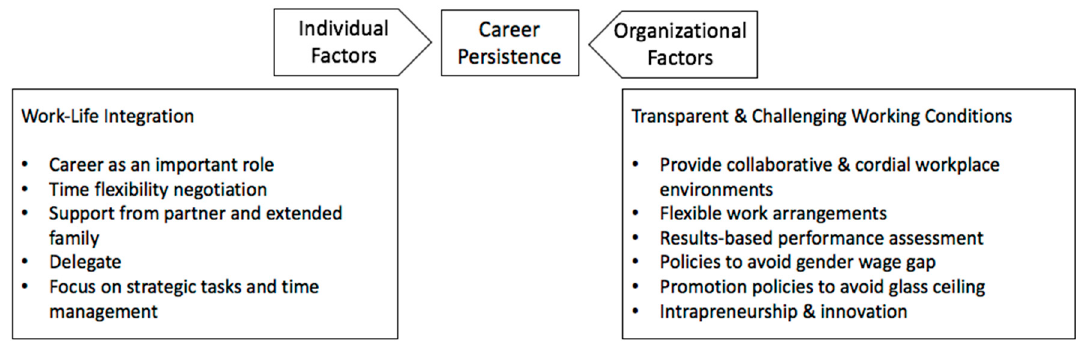
Figure 2. Factors that impact persistence and retention of women in senior management. Source: Salvaj and Kuschel (forthcoming). Salvaj and Kuschel